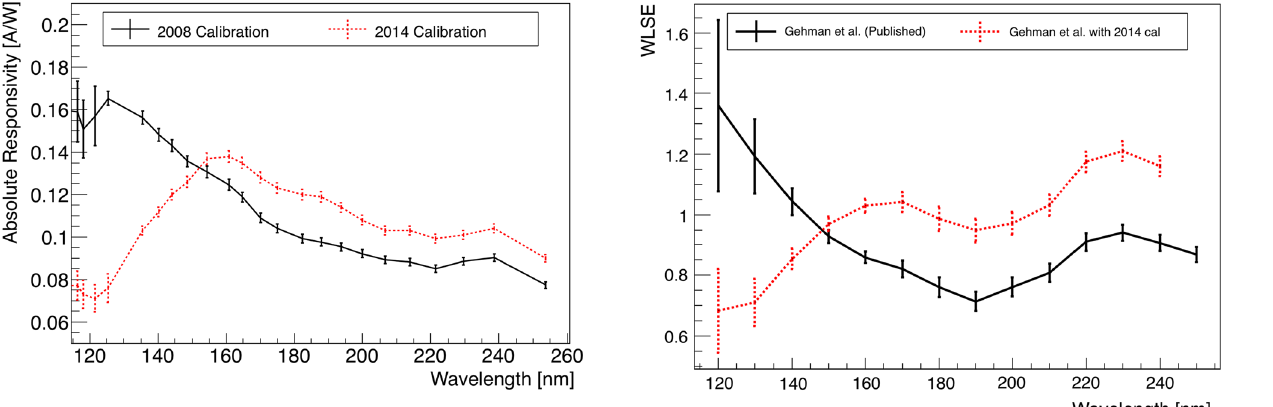
Fig. 21 AcomparisoncomparisonoftheNISTcalibrationsofthepho- todiode used in [16] in 2008 (solid) and in 2014 (dotted). The 2008 curve was used as the photodiode response function in [16]. There is a substantial difference between the 2008 and 2014 response functions, suggesting that significant degradation in the photodiode’s response occurred between 2008 and 2014